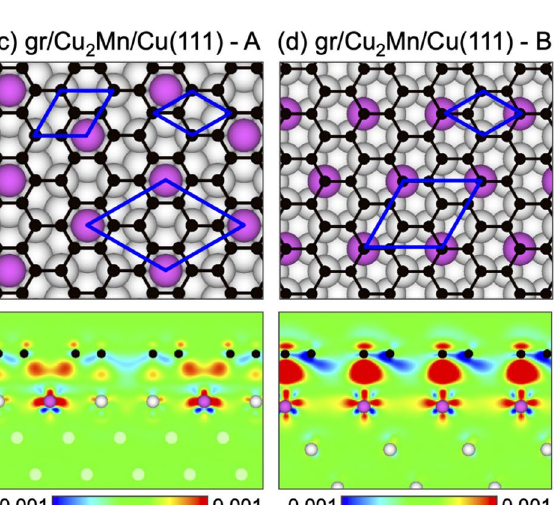
Cu 2 Mn with √ 3 ) R 30 ◦ superstructure of ×